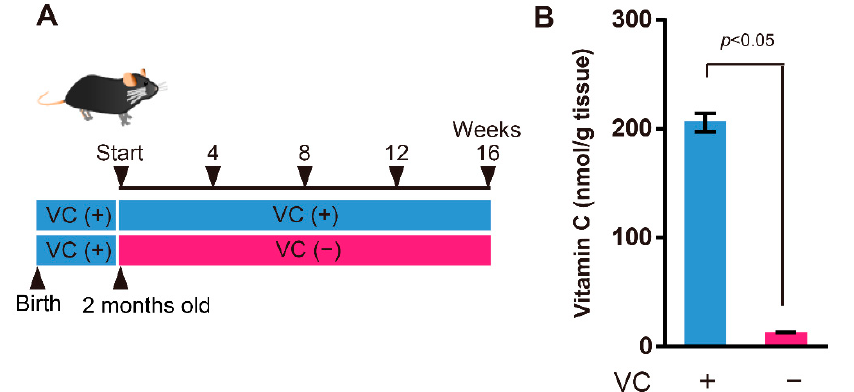
Figure 1. VC levels in gastrocnemius muscles. ( A ) Experimental procedure. Mice drank 1.5 g/L VC in water until two months old. Then, mice were divided into two groups: VC-treated (VC(+)) group and VC-untreated (VC( − )) group. The VC(+) group drank 1.5 g/L VC in water, whereas the VC( − ) group drank water without VC for a sixteen-week period. ( B ) Total VC levels in the gastrocnemius muscles at four weeks. Values are given as the mean ± SEM of five animals. Statistical differences were considered significant at p < 0.05 between VC(+) and VC( − ) groups.